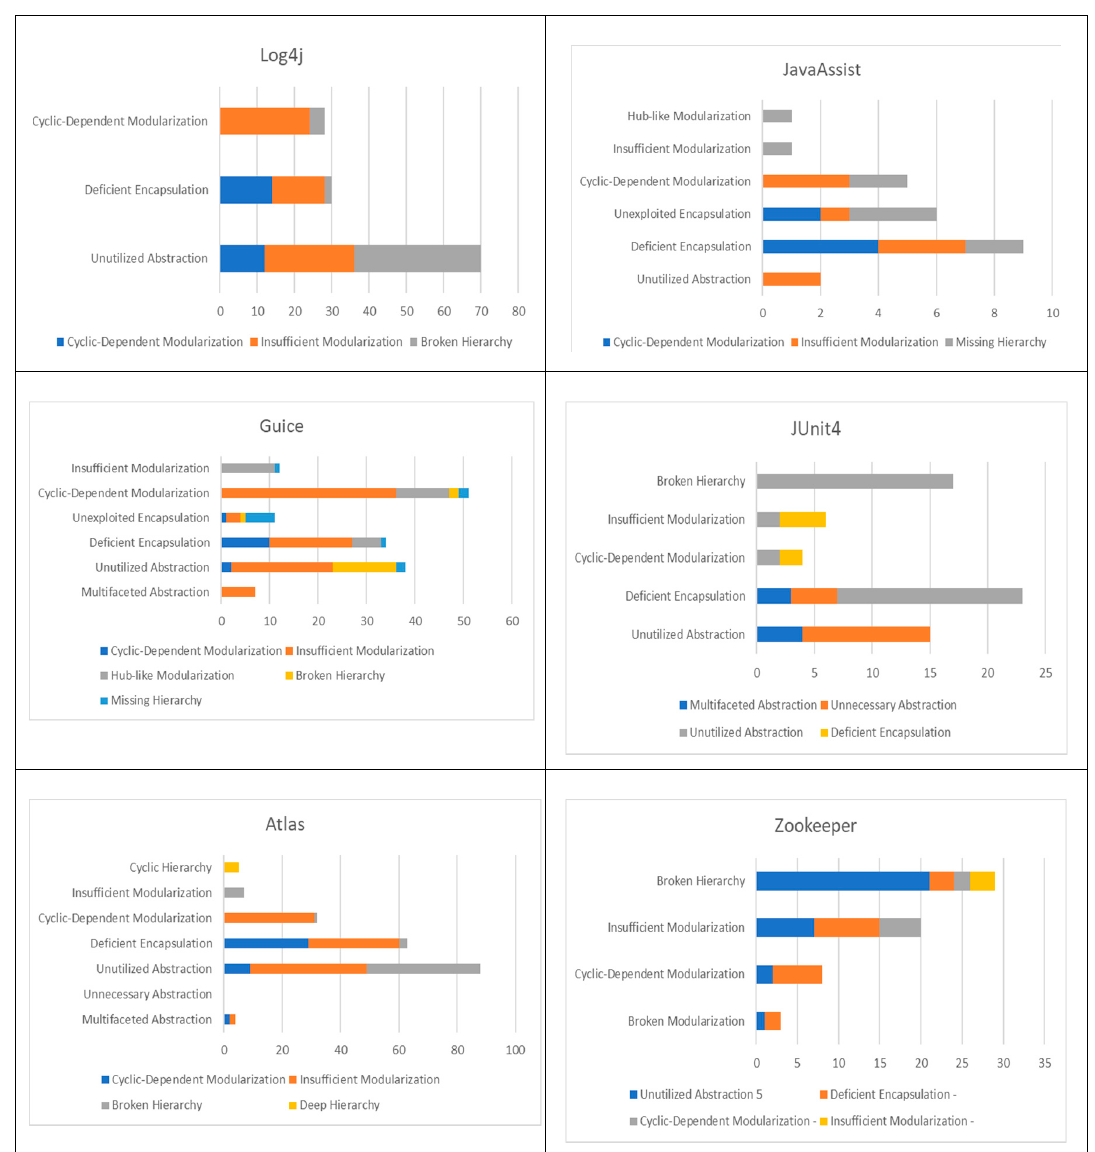
Figure 6. Number of co-removed smells.